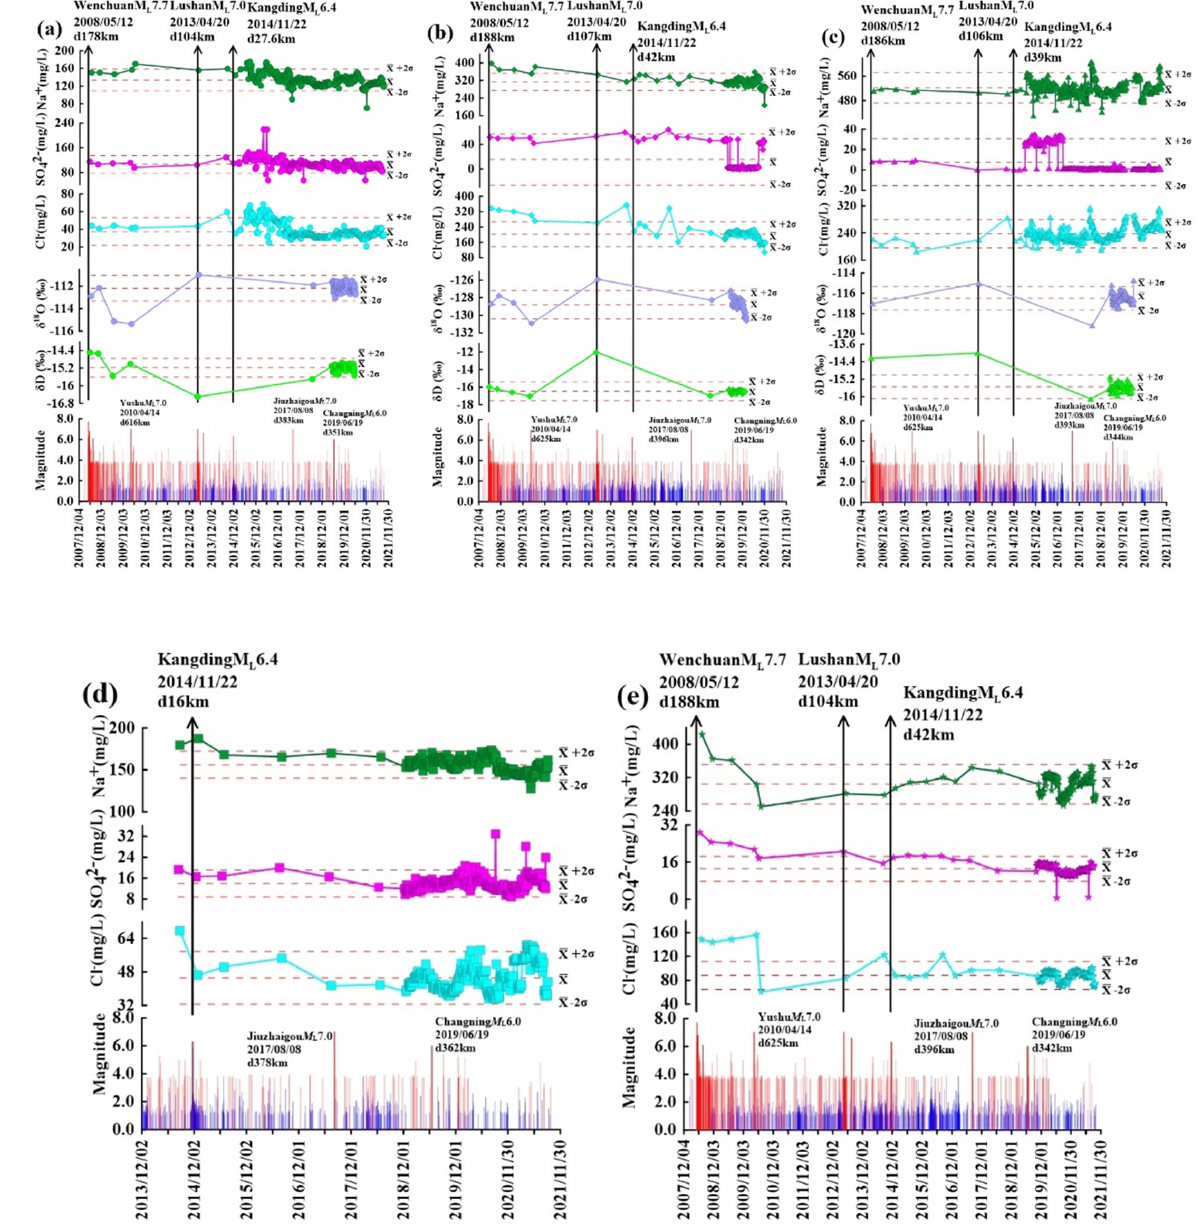
Figure 9. Temporal variations of concentration of Na + , Cl − , SO 42 − , δ D, δ 18 O and earthquake: ( a ) is the Erdaoqiao spring (W30); ( b ) is the Guanding spring (W34); ( c ) is the Longtougou spring(W31); ( d ) is the Mugecuo spring (W27) and ( e ) is the Xinxingxiang spring (W37), Blue bars show the near-field earthquakes within 50 km and magnitude range from M L 1.0 to M L 3.0. Red bars show the far-field earthquakes within 300 km and magnitude range over M L 3.0. Hydrogen and oxygen isotope data for 2019–2020 in the figure are from Zhang et al. (2021)